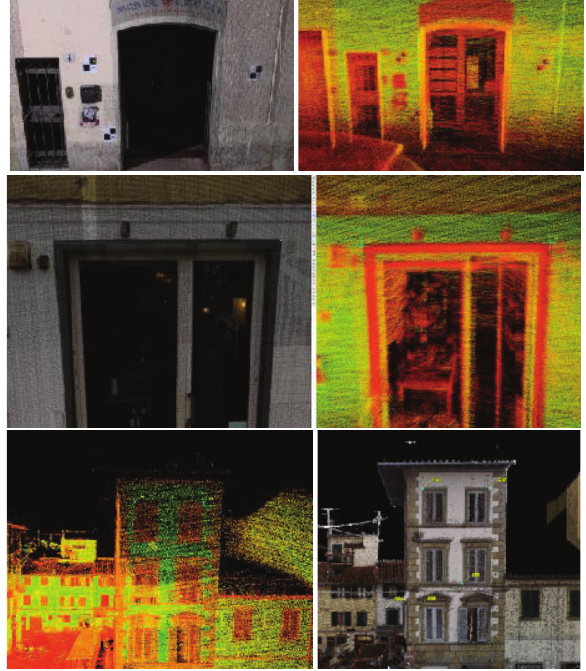
Figure 7. Comparison of how the images appear extrapolated from the point cloud generated by the mobile laser scanner (KAARTA Stencil) and from the RGB acquisition of the terrestrial laser scanner (FARO Cam Focus S150).